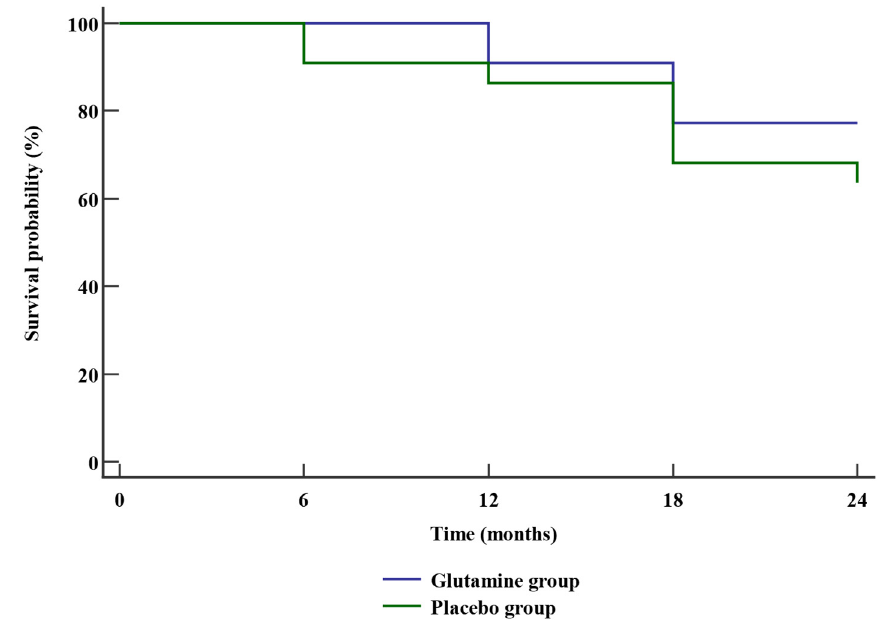
Figure 2. Kaplan–Meier curve for overall survival.